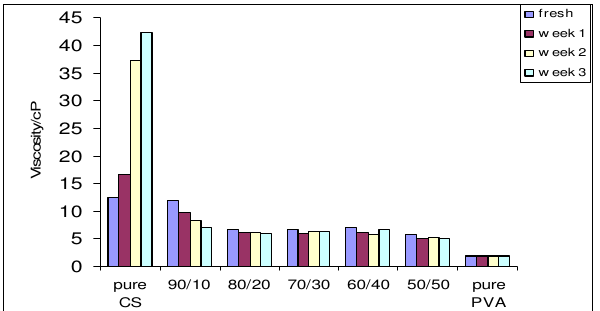
Figure 4. The effect of storage time on the shearing viscosity (determined at 6.15 s -1 ) of CS/PVA mixture solutions (SD is very